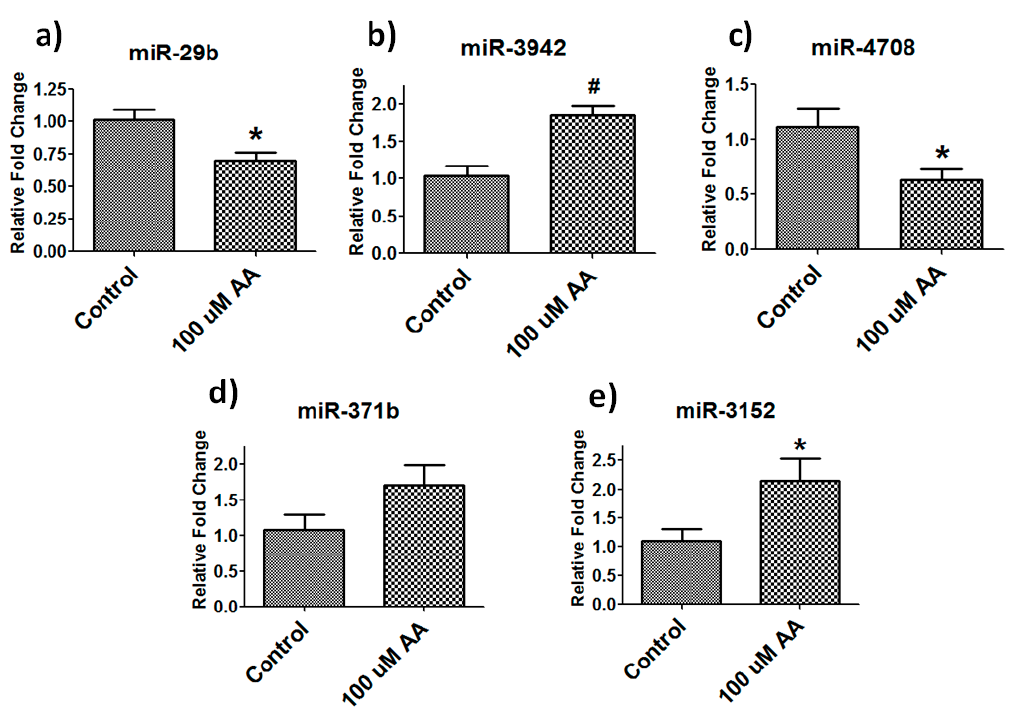
Figure 4. Validation of miRNA array data on randomly picked miRNAs. Real-time PCR showing change in miRNA expression in vitamin C (100 µ M) treated samples compared to control ( a ) miR-29b; ( b ) miR-3942; ( c ) miR-4708; ( d ) miR-371b and ( e ) miR-3152 ( n = 4–6, * p = 0.05, # p = 0.01).